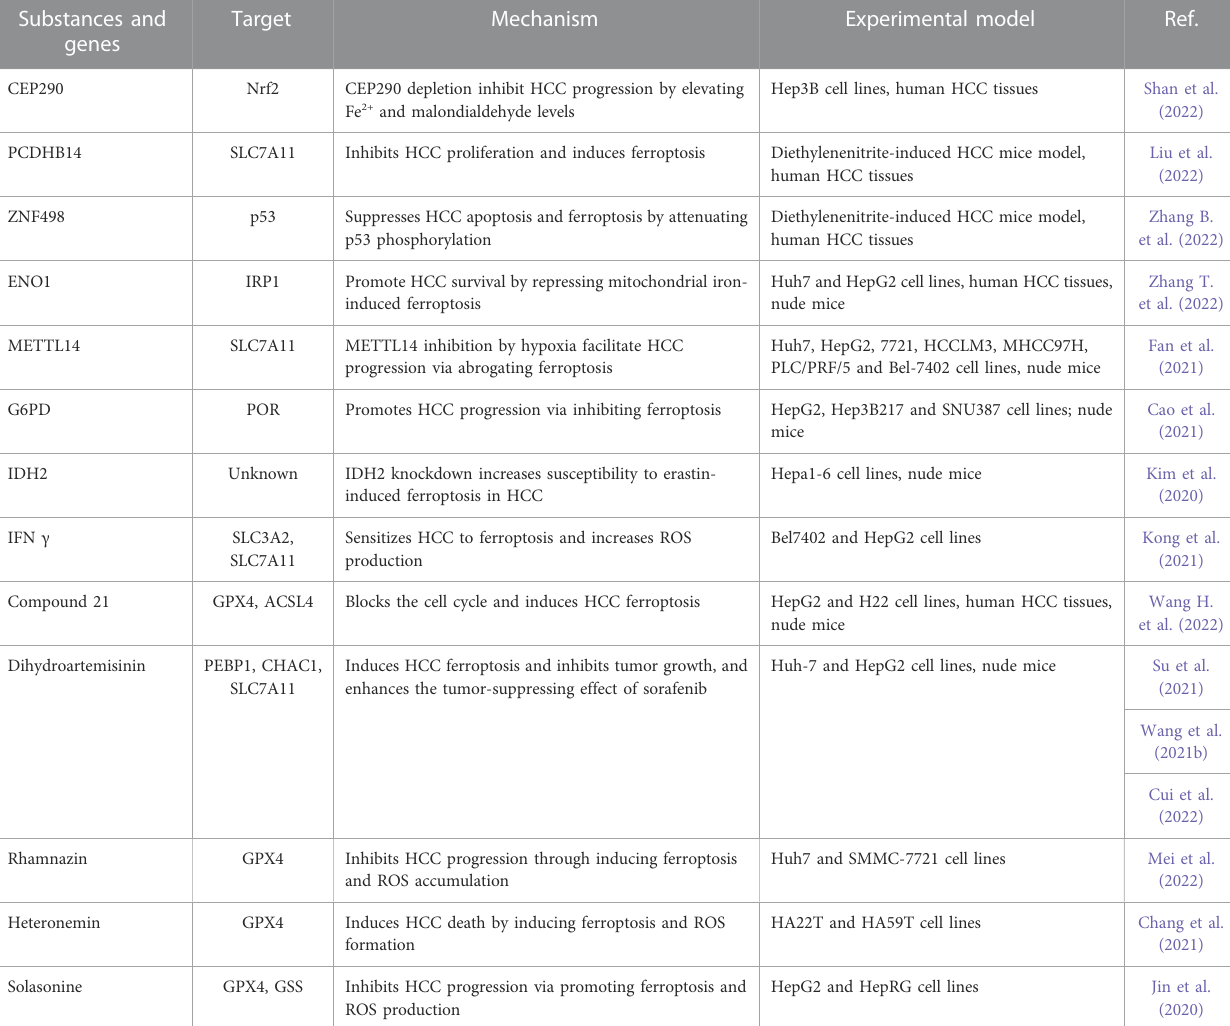
TABLE 1 Candidate substances and genes for inducing ferroptosis in HCC. Substances and